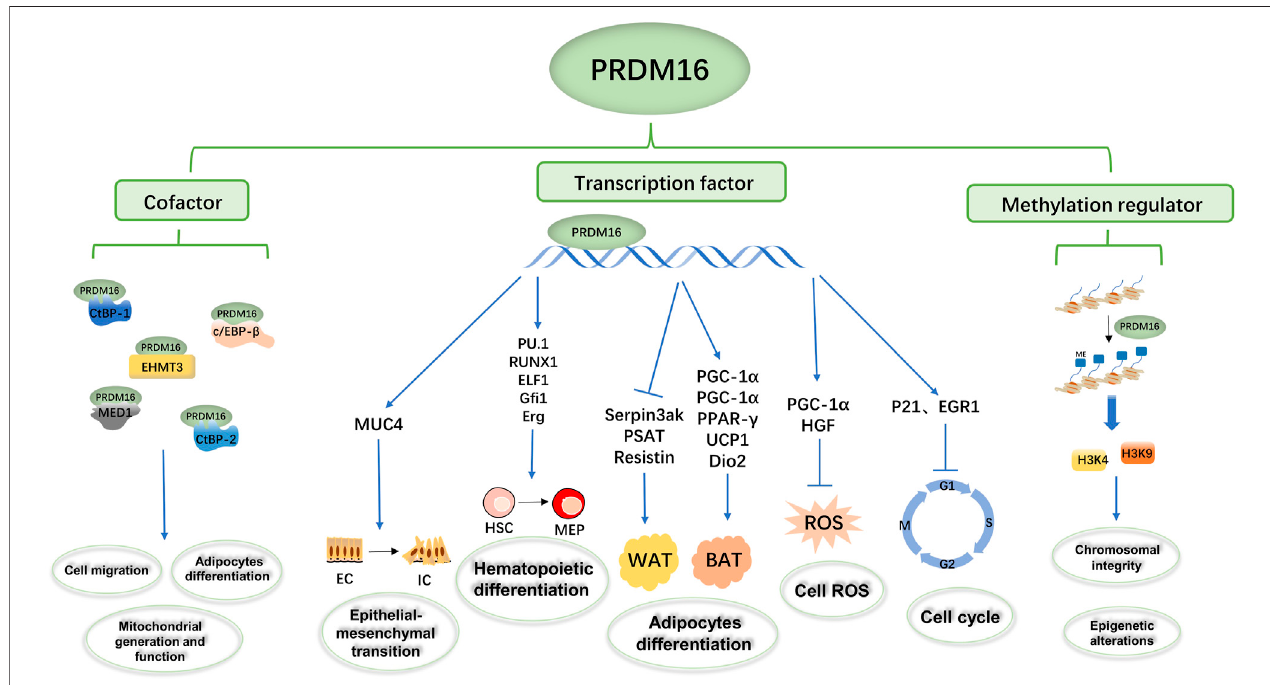
FIGURE2| SummaryofthebiologicalfunctionsofPRDM16.ThePRDM16PRdomainparticipatesinbiologicalmetabolismasatranscriptionfactor,cofactor,and methylation regulator. PRDM16 could mediate epithelial – mesenchymal transformation by regulating MUC4 transcription, hematopoietic differentiation by regulating PU1, Runx1, ELF1, G fi 1, and ERG transcription, adipocyte differentiation by regulating PGC-1 α , PGC-1 β , PPAR- γ , UCP1, Dio2, Serpin3ak, PSAT1, and resistin transcription, and cell ROS and the cell cycle by regulating PGC-1 α , HGF, P21, and EGFR transcription. In addition, PRDM16 could bind with c/EBP- β , CTBP-1, CTBP-2, EHMT3, and MED1 as transcription complexes involved in cell migration, adipocyte differentiation, and mitochondrial generation and function. Moreover, PRDM16 could mediate the methylation of H3K9 and H3K4 and then in fl uence chromosomal integrity and epigenetic alterations.